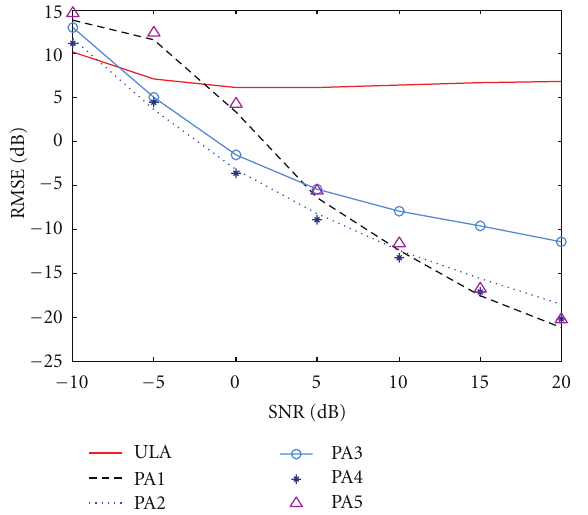
Figure 11: Total RMSE of the MVDR algorithm for di ff erent combined array configurations in scenario